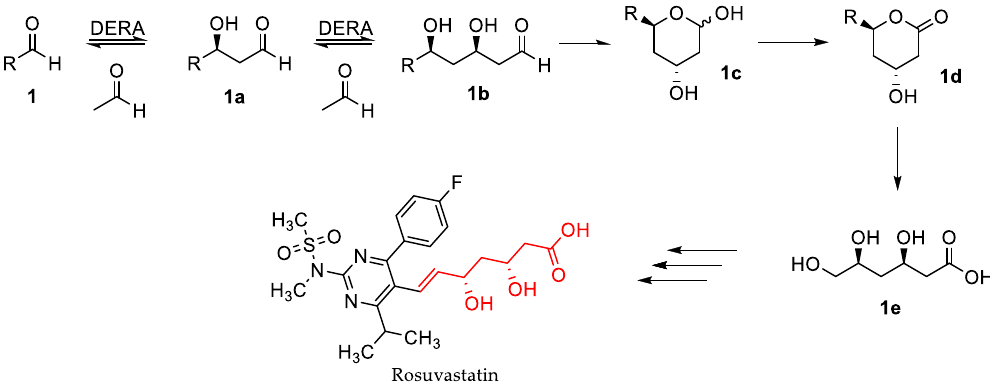
Figure 2. Deoxyribose-5-phosphate aldolase (DERA)-catalyzed stereoselective aldol addition of three aldehydes to produce a lactol ( 1c ), which can be further oxidized to a lactone results in the typical statin side chain after ring-opening.